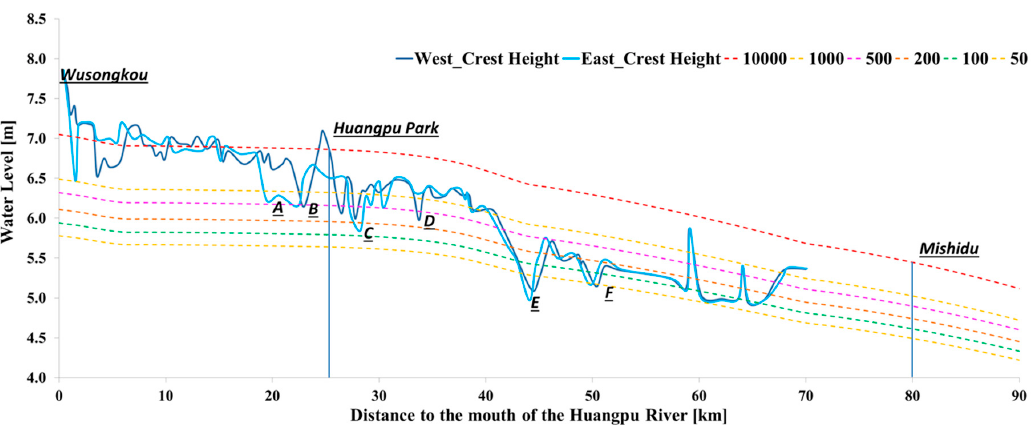
Figure 6. A comparison of crest height of the floodwall with the water level for various return periods for the Huangpu River in